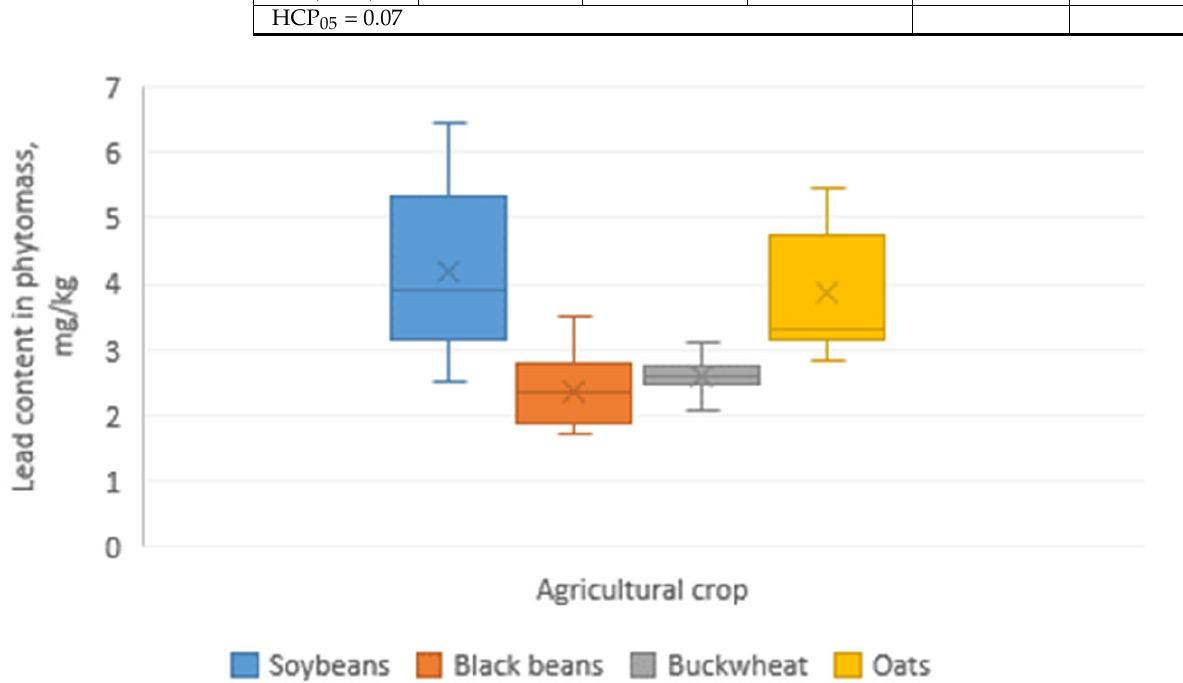
Figure 3. Diagram of lead content in the phytomass of test crops on the variants of the vegetation experiment depending on the values of the total index of soil contamination.